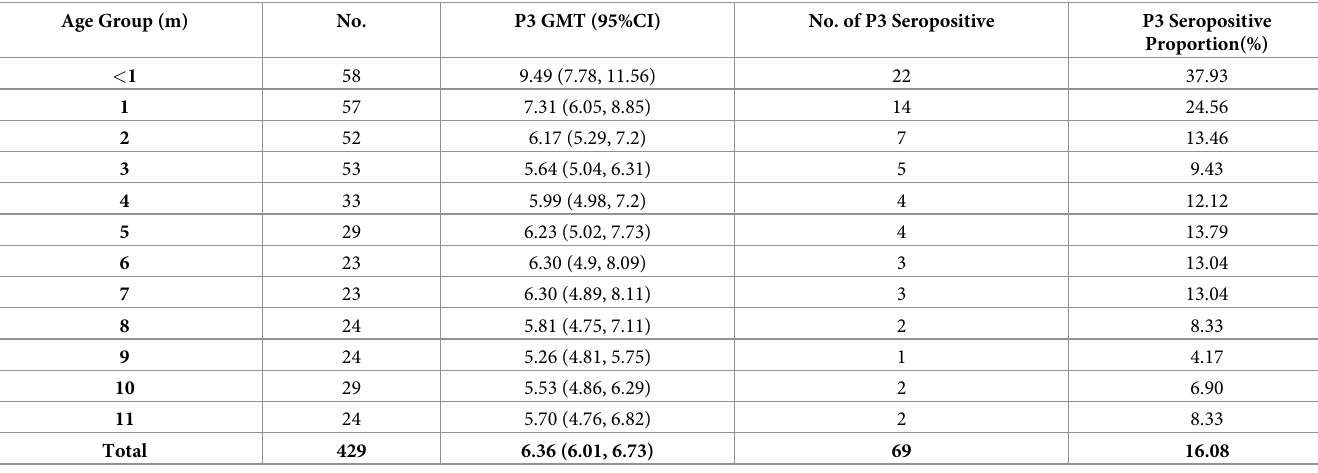
Table 1. Japanese encephalitis neutralizing antibody and seropositive proportion against P3 strain for participants under 1 year old in Zhejiang, 2015–2016. Age Group